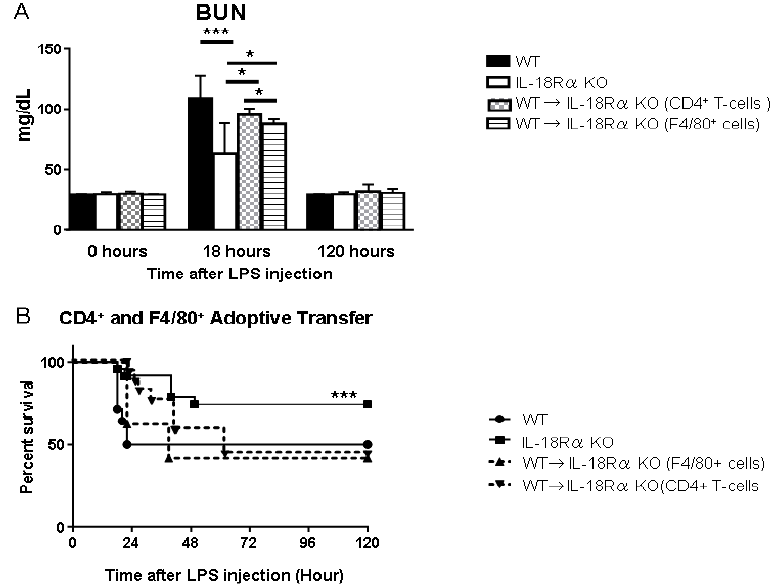
Figure 7. Effect of splenocyte transfer on renal function and survival rates. ( A ) CD4 + T cells and F4/80 + cells (2 × 10 6 /mouse) from splenocytes of C57BL/6 WT mice were injected intravenously into each IL-18R α KO mouse two days before LPS injection. Mice were sacrificed at 0 (each group; n = 3), 18 ( n = 5 and n = 9) and 120 h ( n = 5 and n = 7) after LPS injection. The data are the mean ± SEM (* p < 0.05, *** p < 0.005). ( B ) The survival of the WT mice, the IL-18R α KO mice and the IL-18R α KO